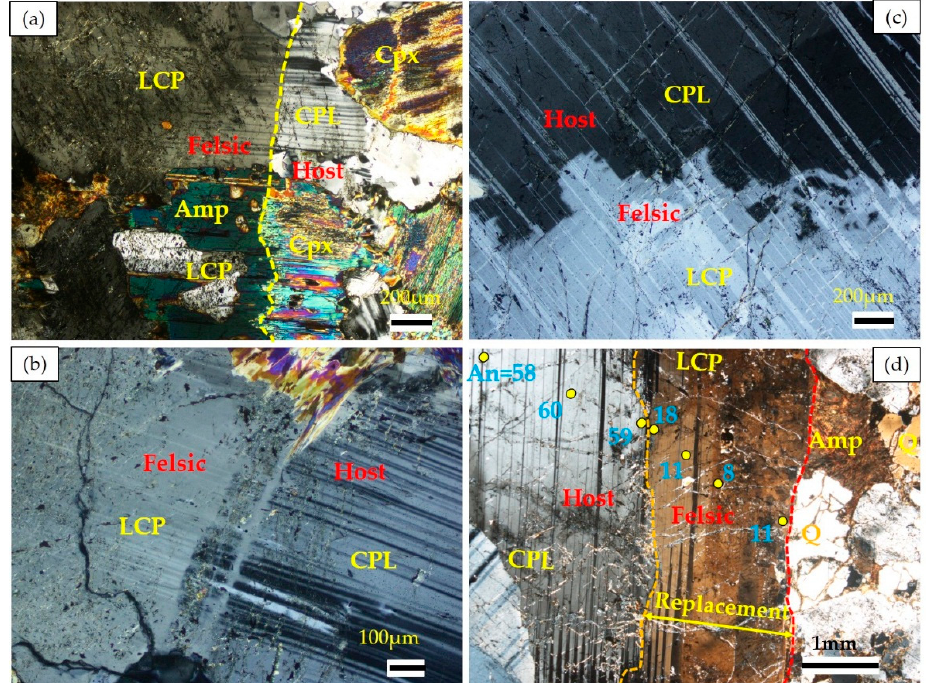
Figure 6. Closed-up replacement texture photomicrographs at felsic veins boundaries—Hole U1473A. ( a , b ) Sample 66R5, 1–7 cm; clinopyroxene and calcic plagioclase were partially converted to brown amphibole and less calcic plagioclase, respectively. ( c , d ) Sample 66R4, 46–49 cm; reaction interface and the replacement of plagioclase. CPL: Calcic plagioclase. LCP: Less calcic plagioclase. Cpx: Clinopyroxene. Amp: Amphibole. Q: Quartz.